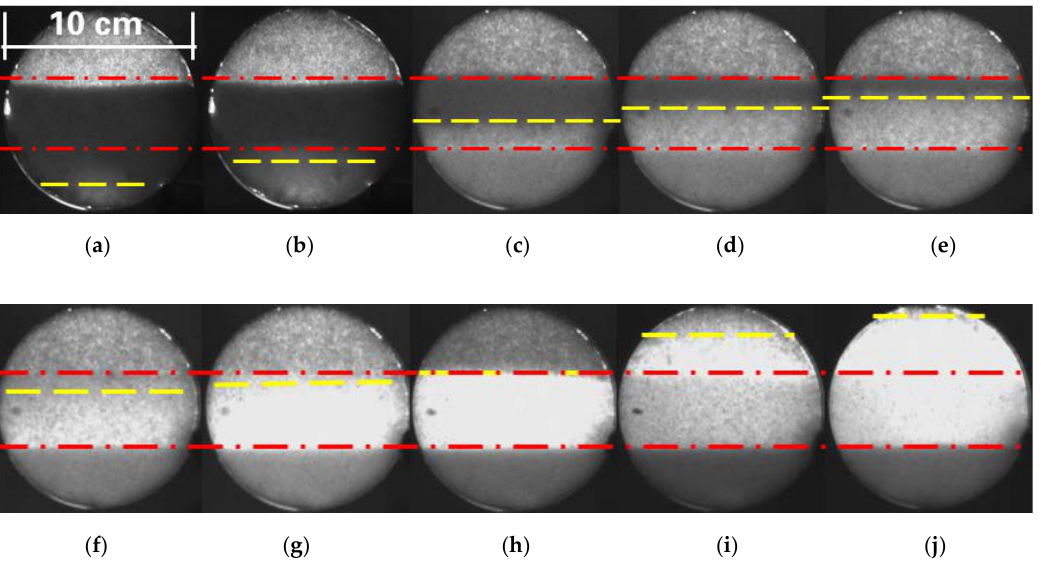
Figure 4. Interface migration of oil saturation process. ( a ) 0.21 HCPV, ( b ) 0.42 HCPV, ( c ) 0.62 HCPV, ( d ) 0.80 HCPV, ( e ) 1.03 HCPV, ( f ) 1.27 HCPV, ( g ) 1.42 HCPV, ( h ) 1.63 HCPV, ( i ) 1.83 HCPV, ( j ) 2.23 HCPV. Note: The yellow dotted line is the saturated oil interface; the red dotted line is the interface between layers with different permeability.